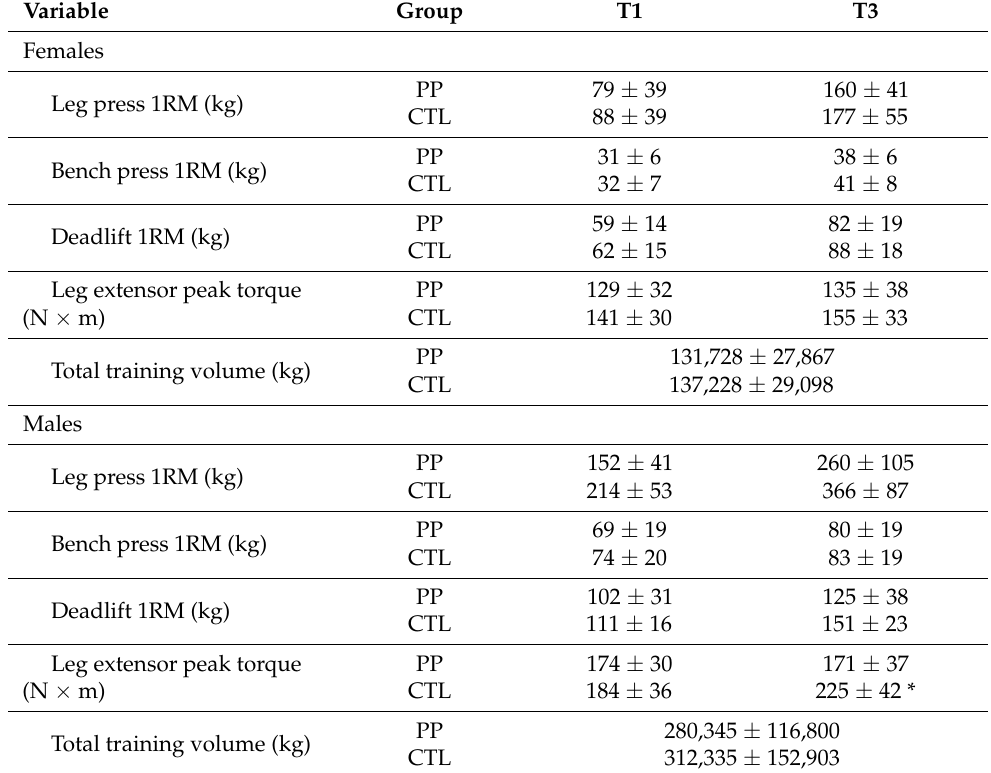
Table 5. Strength adaptation